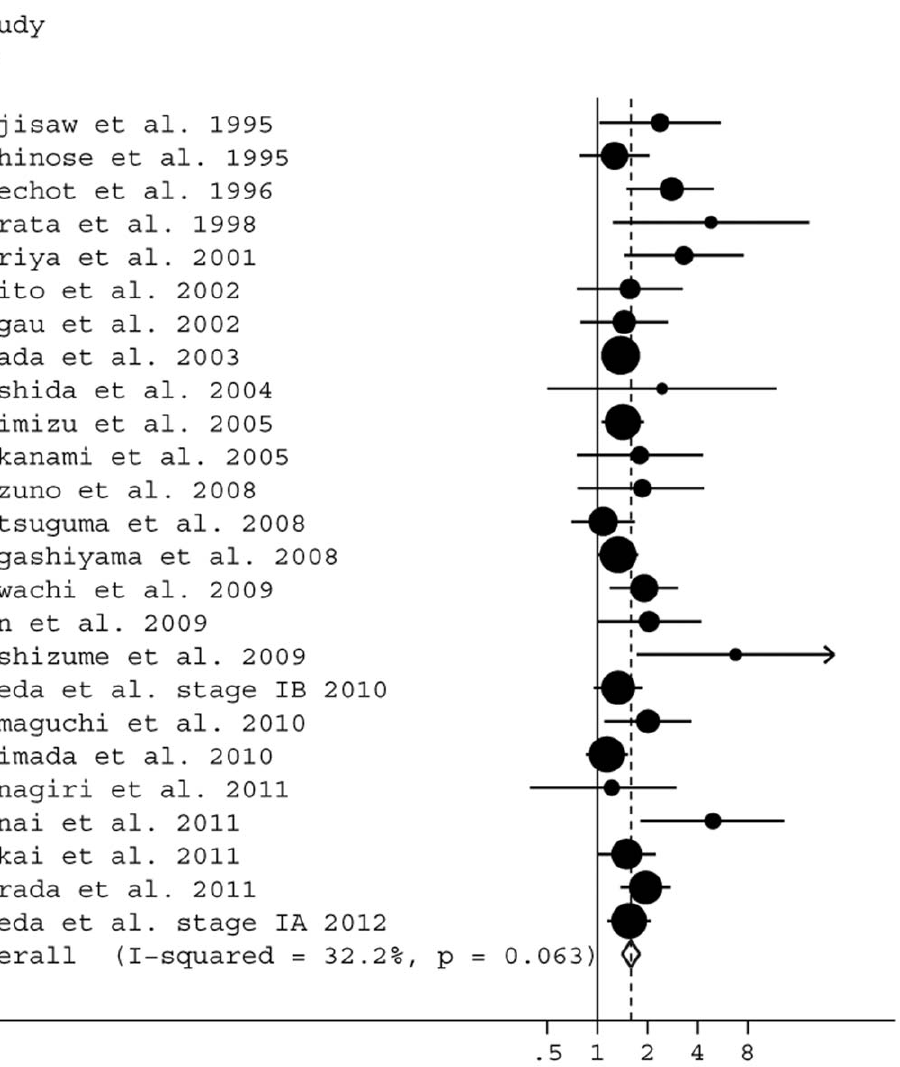
Figure 2. Forest plot showing the combined relative hazard ratio for overall survival in all patient populations by multivariate analysis.